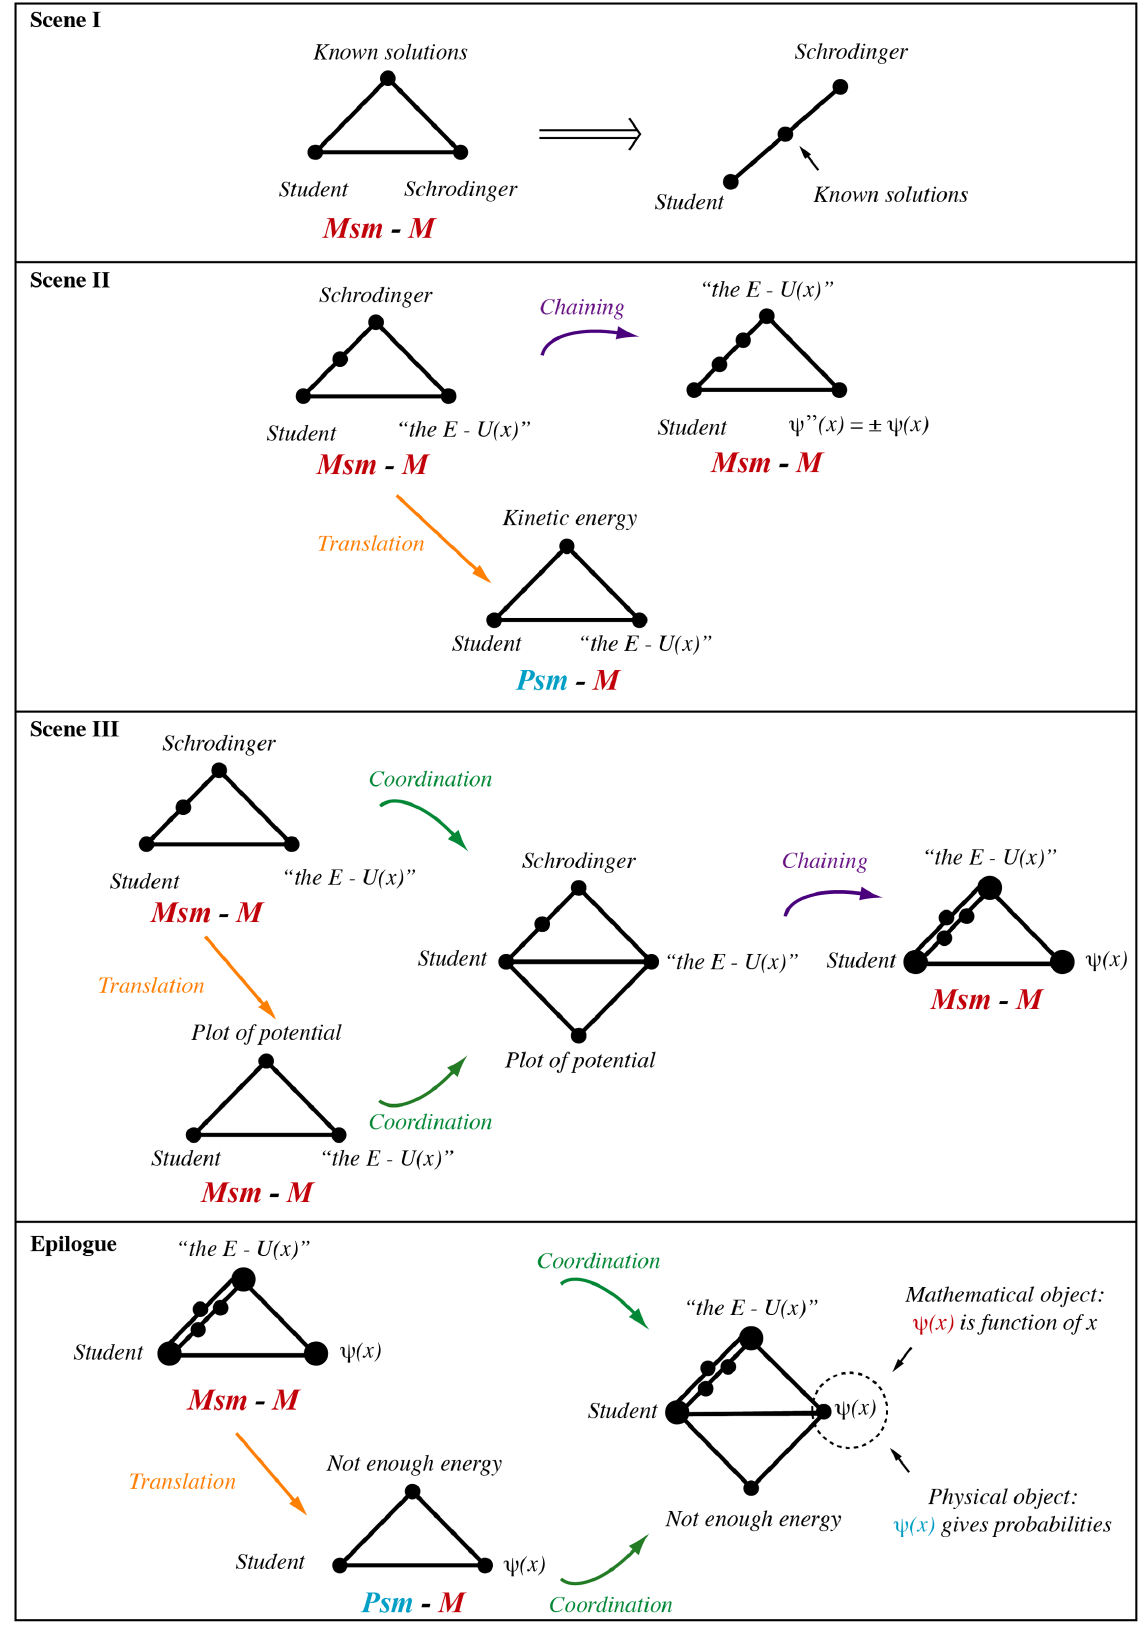
FIG. 12. A sense making diagram for the analysis of the three scenes, prologue, and epilogue of case study